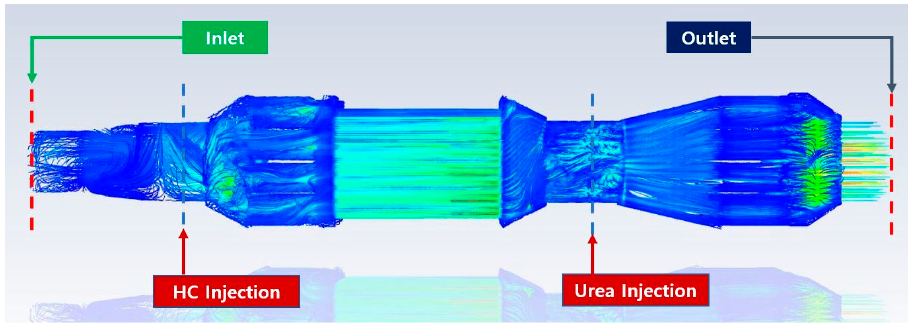
Figure 3. Velocity magnitude schematic of rectangle-type PM/NO X aftertreatment system.